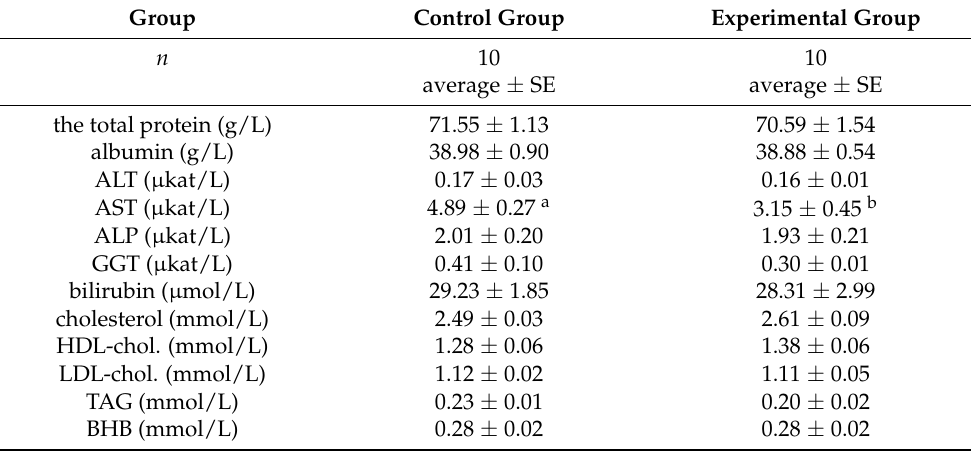
SE: mean standard error. a,b averages of the same order marked by various letters are significantly different from each other ( p < 0.05). Significant differences in the blood parameters were observed between the groups in the biochemical values after exposure to physical exercise. Statistically significant differences in AST, NEFA, and Pi values (Table 5) were detected between the groups in the sampling after 15 min after exercise (third sample). The same results as in the second sample (higher creatine kinase values, lower ALP, and higher AST in the control group) were monitored in relation to the reference range of the values. Table 5. Blood sample three: up to 15 min after the end of physical exercise on day 56. Group Control Group Experimental